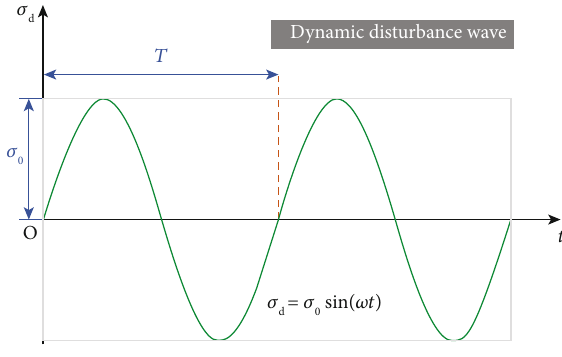
under dynamic loading. 1